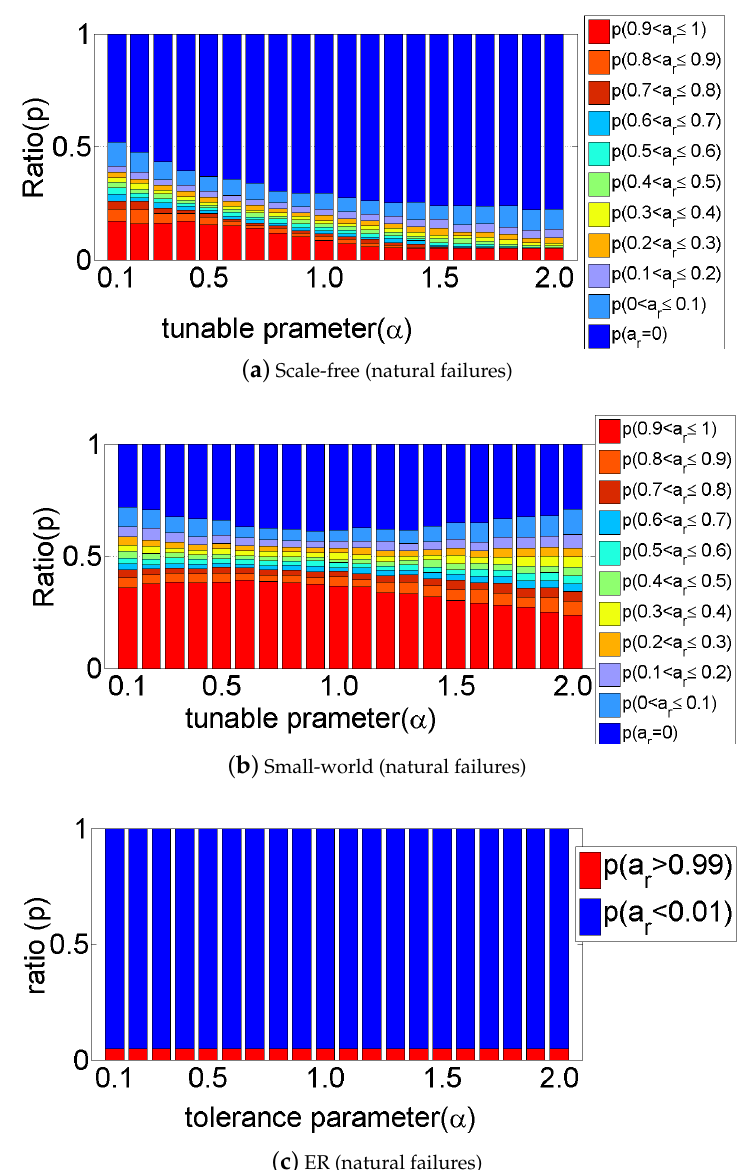
Figure 1. Probabilities of cascading failures under natural failure conditions for three network types. ER,